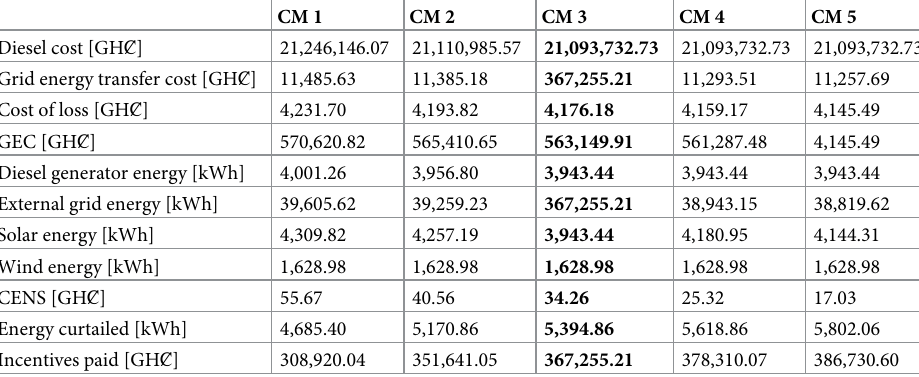
Table 15. Influence of varying CM on a network–case